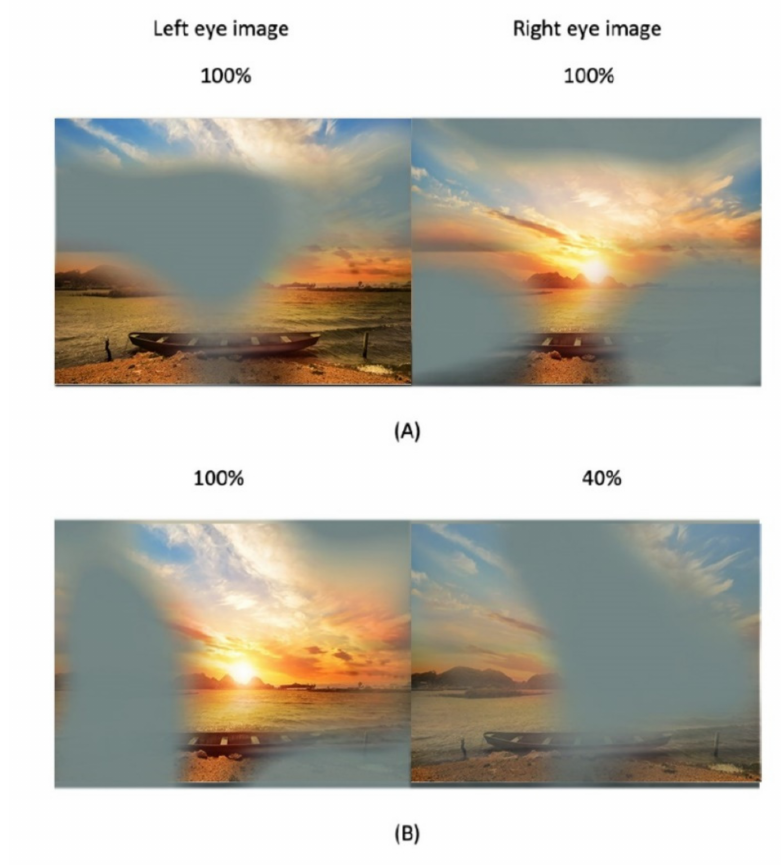
Figure 5. Illustration of the dichoptic movies. The two eyes’ views are shown side by side. Com- plementary patterned image masks composed of irregularly shaped blobs were overlaid over the images seen by the two eyes. The shape and location of the blobs were varied dynamically every 10 s. ( A ) 100% contrast images were presented to the two eyes. ( B ) A 100% contrast image is presented to the left eye, and an image with a contrast reduced to 40% is presented to the right